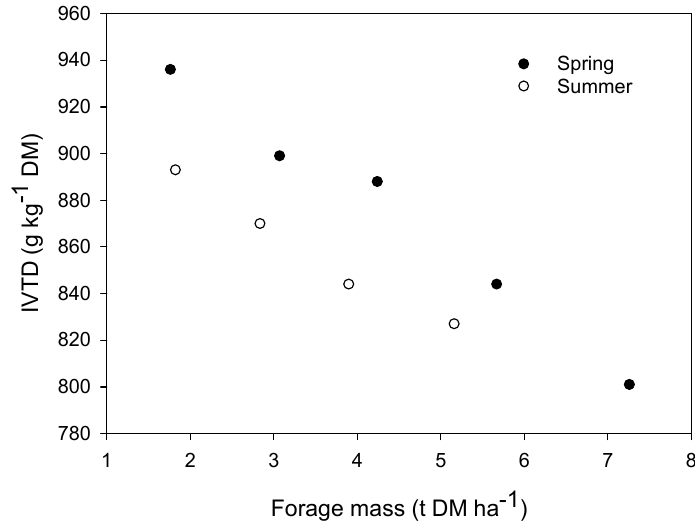
Figure 4. Relationship between in vitro forage digestibili (IVTD) and forage mass (W) of timothy during spring and summer regrowth under non-limiting N conditions. Redrawn from Bélanger and McQueen [32].